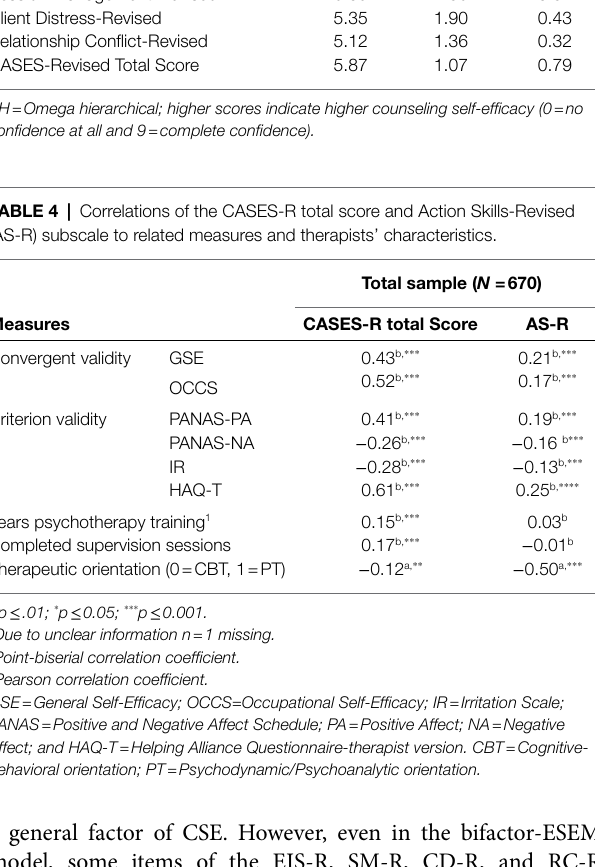
TABLE 3 | Means, standard deviations, and omega hierarchical coefficients for the CASES-R in the total sample ( N = 670). Factors M SD ω H Exploration and Insight Skills-Revised